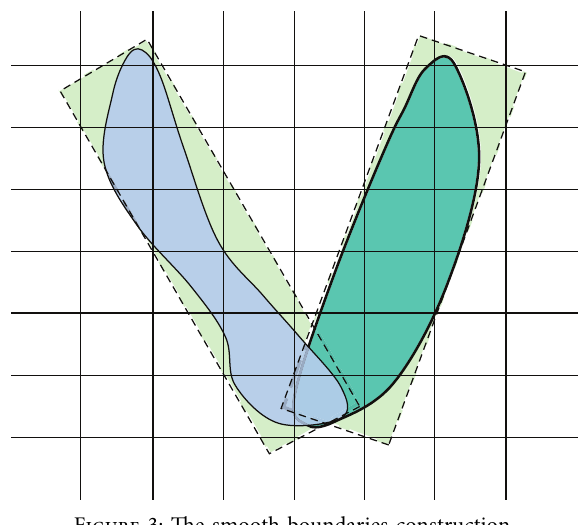
Figure 3: The smooth boundaries